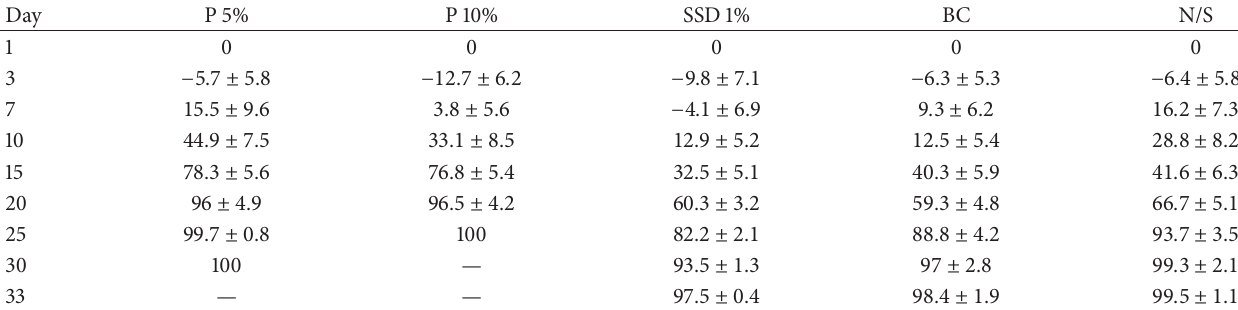
Table 1: Comparison of the percentage of wound contraction between Punica granatum and treated groups ∗ .